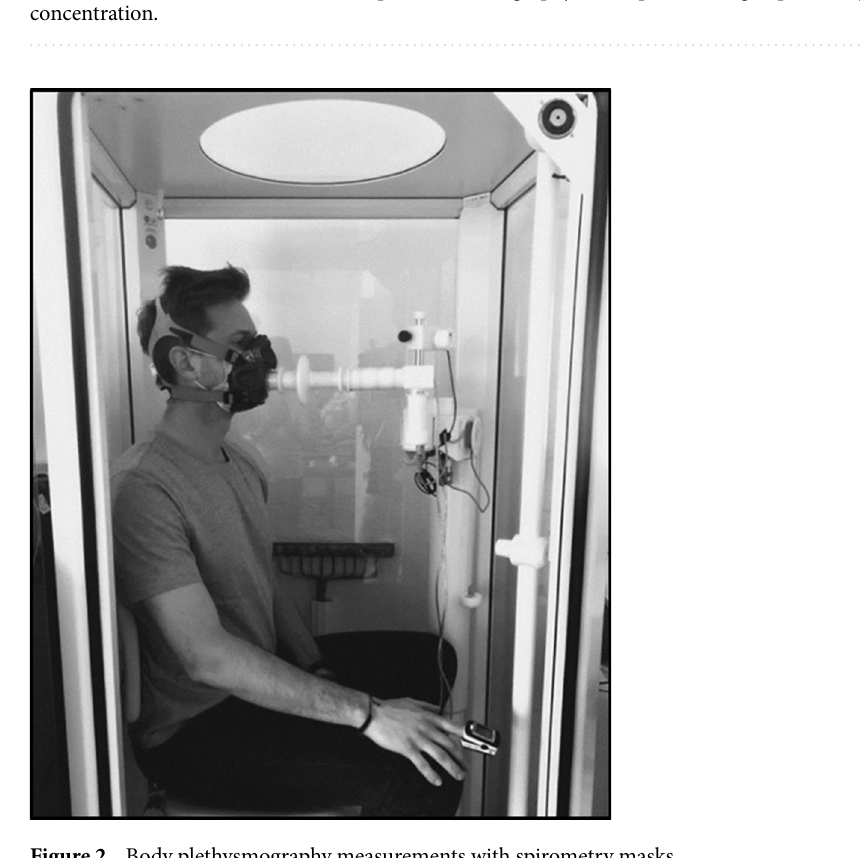
Figure 2. Body plethysmography measurements with spirometry